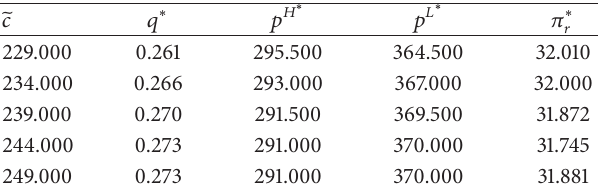
Table 4: Effects of emergency ordering